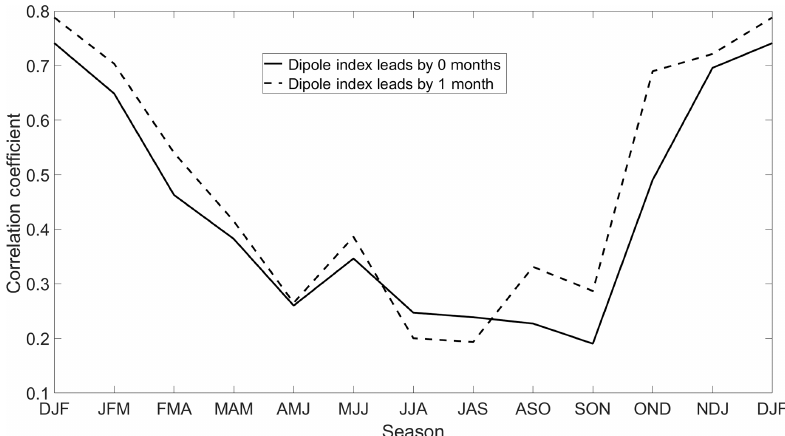
Figure 7. Lagged and simultaneous correlations between seasonally averaged LIS water temperature anomalies and the seasonally averaged dipole index. The dotted line represents the correlation between the dipole index of the prior season (dipole leads by 1 month) and water temperature anomalies for the season specified on the horizonal axis.